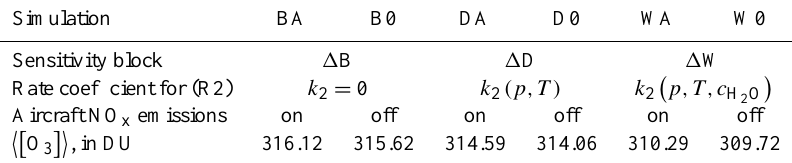
Table 1. Simulations performed for this study. They differ only in the rate coefficient for the HNO 3 -forming channel of HO 2 + NO (Reaction R2) and aircraft NO x emissions. The rate coefficient k 2 is either zero ( B ase), depended on pressure and temperature ( D ry), or additionally on water vapour concentration ( W et). A viation is on ( A ) or zero ( 0 ). Each pair of simulations with identical treatment of (R2) defines